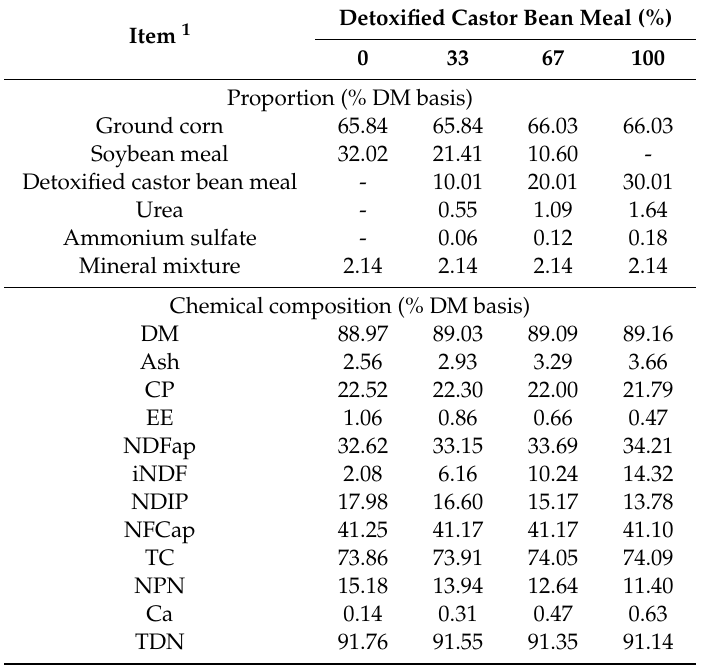
Table 2. Proportion of ingredients and chemical composition of the supplements. Item 1